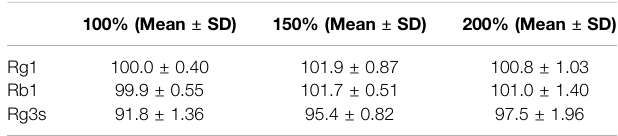
TABLE 2 | Accuracy and percentage recoveray of HPLC analysis.